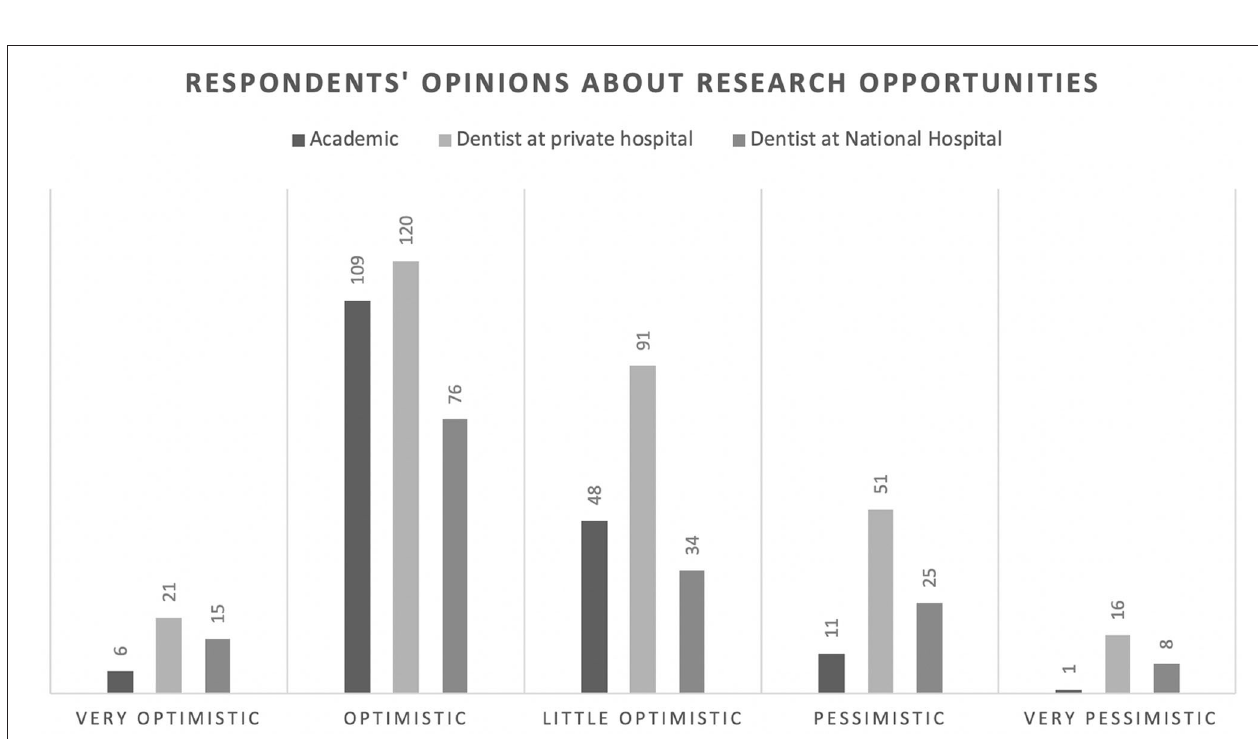
FIGURE 6 | All respondents were optimistic regarding research opportunities ( p < 0.01).